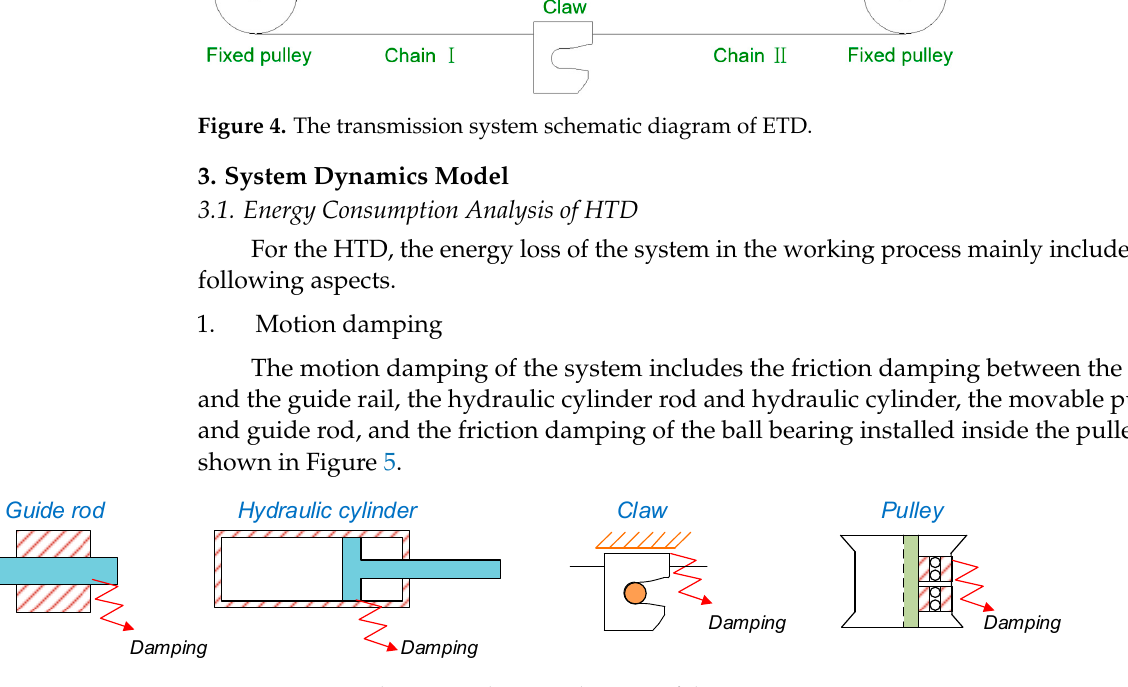
Figure 5. Motion damping schematic diagram of the HTD.